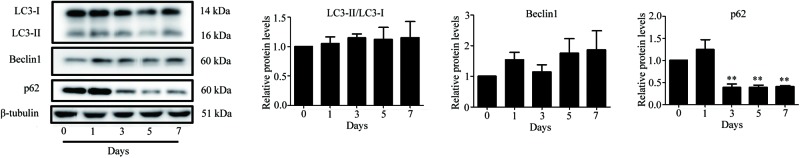
Increased autophagic activity during adipogenic differentiation of TSCs. TSCs were treated with rosiglitazone as indicated intervals. The expression levels of several autophagy markers, including LC3, Beclin1, and p62 were determined by Western blot analysis. Densitometric quantification data are expressed as the intensity ratio of target proteins to β-tubulin. ∗∗p < 0.01.